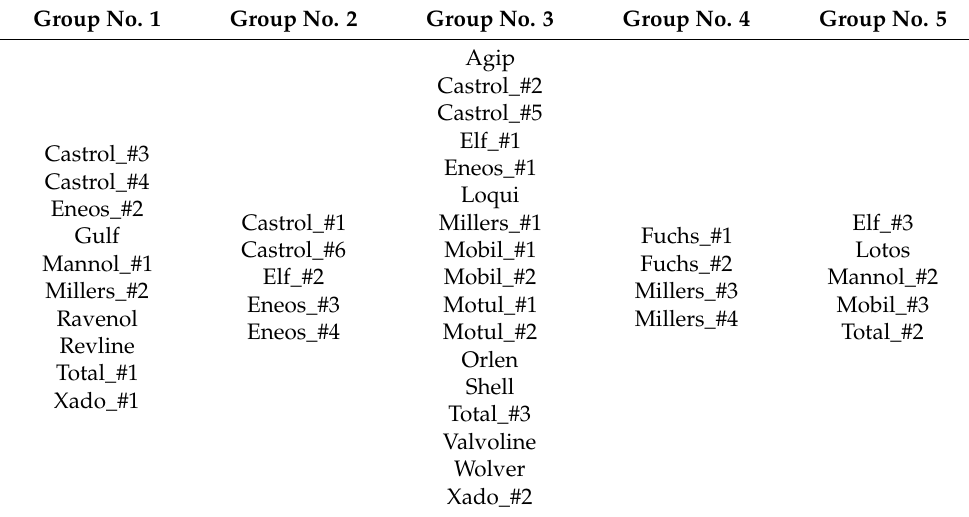
Table 3. Assignment of the oils into the different groupings according to similarity in impedance magnitude values.